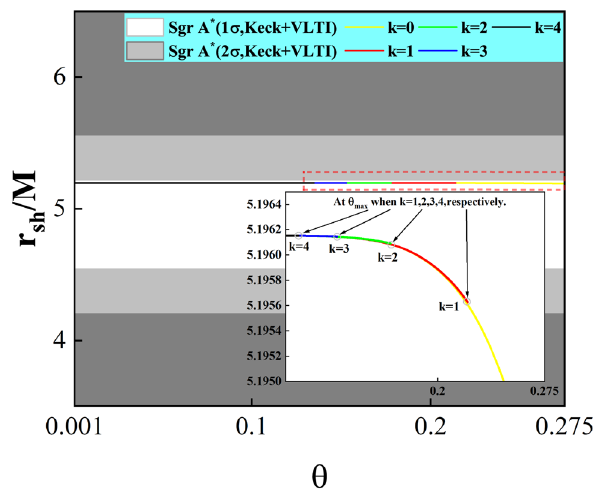
Fig. 2 Shadow radius r sh of 4 − D non-commutative Schwarzschild– Tangherlini black hole as a function of the non-commutative parameter θ ( k = 0 , 1 , 2 , 3 , 4 corresponding to the Yellow, red, green, blue and black solid lines, respectively). The value of θ starts from θ → 0. The white and light gray zones match the EHT horizon-scale picture of Sgr A*at1 σ and2 σ ,respectively.Thegrayarearepresentsthevalueoutside the limit and satisfy the conservation relation 1 + | A out | 2 = | A in | 2